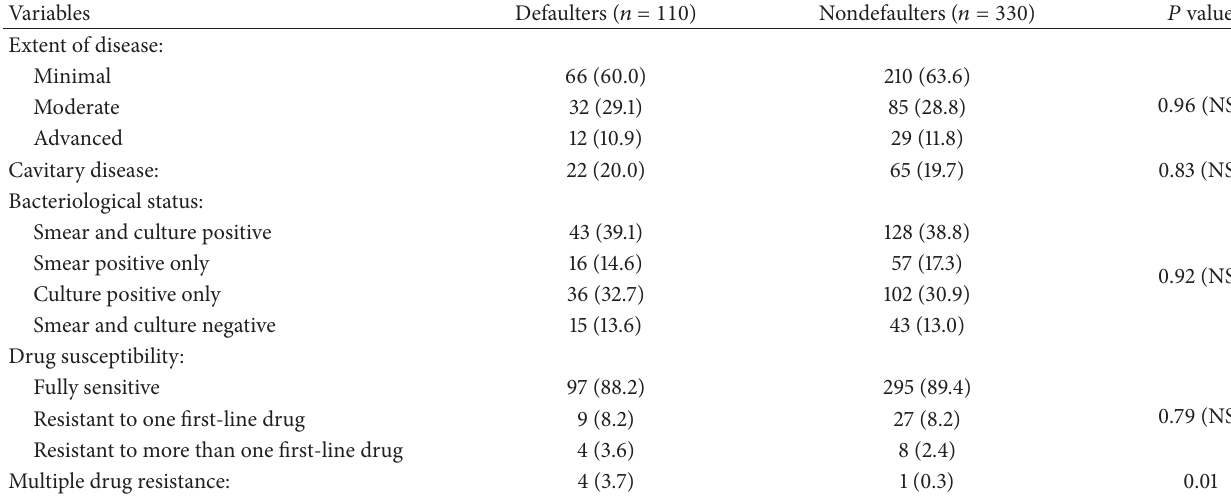
Table 3: Extent of disease, cavitation, bacteriology, and drug susceptibility pattern among defaulters and nondefaulters.